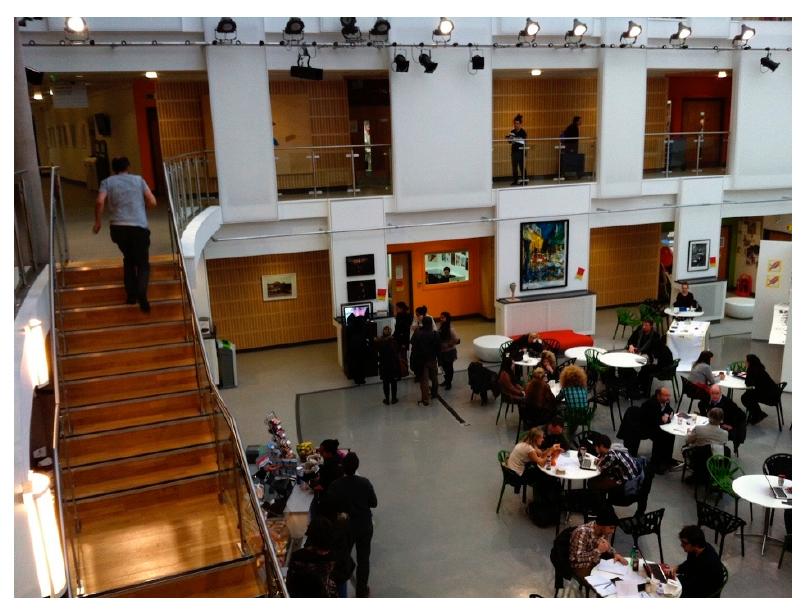
Figure 3. TT kiosk at the university’s cafe. A research aide communicates through the TT with students. Permission granted by Dr Marianne Markowski.